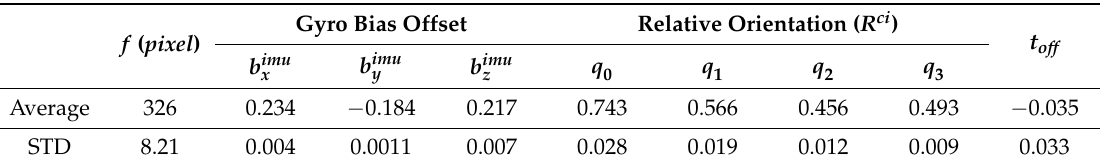
Table 1. The camera and a gyroscope calibration result.